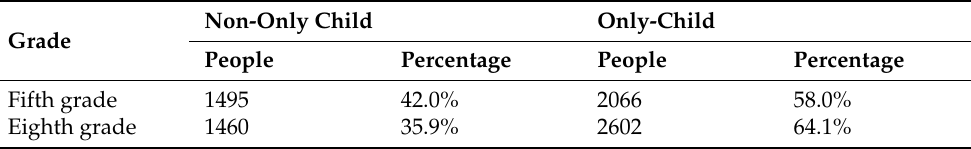
Table 1. Distribution of only-child and non-only-child students in fifth and eighth